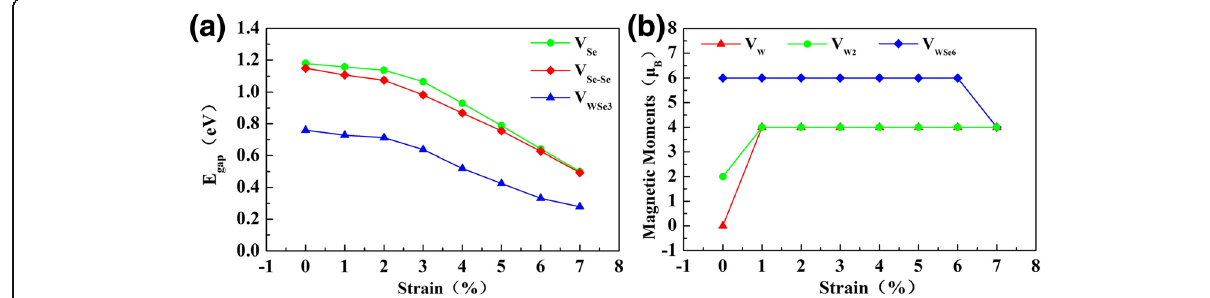
Fig. 6 a The energy gaps of monolayer WSe 2 with V Se , V Se-Se , and V WSe3 vacancies. b The magnetic moments of monolayer WSe 2 with V W , V W2 , and V WSe6 vacancies under the tensile strain of 0~7%.